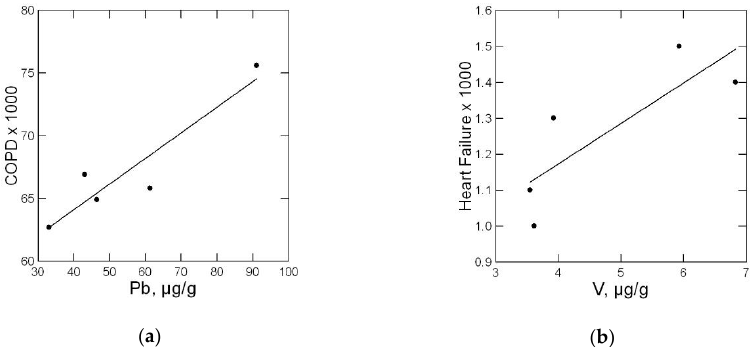
Figure 2. Correlation between the element concentrations and the health indicators of the population living in the five Socio Health Districts of the city of Genoa: ( a ) the relationship between the median value of the Pb concentration (as µg/g) measured in the samples of tree bark and the incidence of chronic respiratory disease (COPD) × 1000 inhabitants ( r = 0.930; p = 0.022); ( b ) the relationship between the median value of the V concentration (as µg/g) measured in the samples of tree bark and the incidence of heart failure × 1000 inhabitants ( r = 0.821; p = 0.089). The observed relationships were confirmed when the element concentrations were related to mortality data for specific causes; significant correlations were found between the Pb concentration and the ischemic SMR ( r = 0.853; p = 0.031; ρ = 0.696; p = 0.100) and between the V concentration and the SMR from circulatory diseases ( r = 0.731; p = 0.099; ρ = 0.754; p = 0.030) (Figure 3).